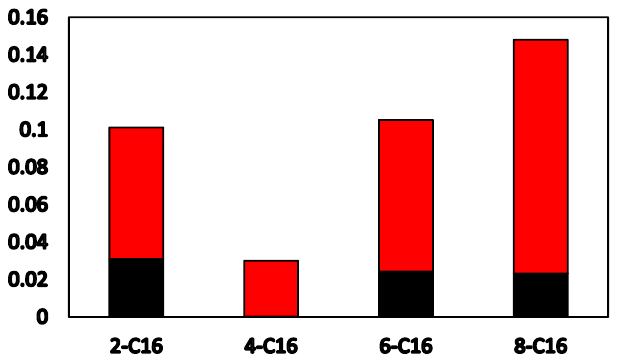
Figure 12. Coordination numbers of different functional groups (red indicates the coordination number of O H and O w , black is the coordination number of O K and O w ). It can be seen that the ketone coordination number of 4 ‐ C16 is almost zero, and the ketone coordination number of the other three isomers is almost the same. The order of